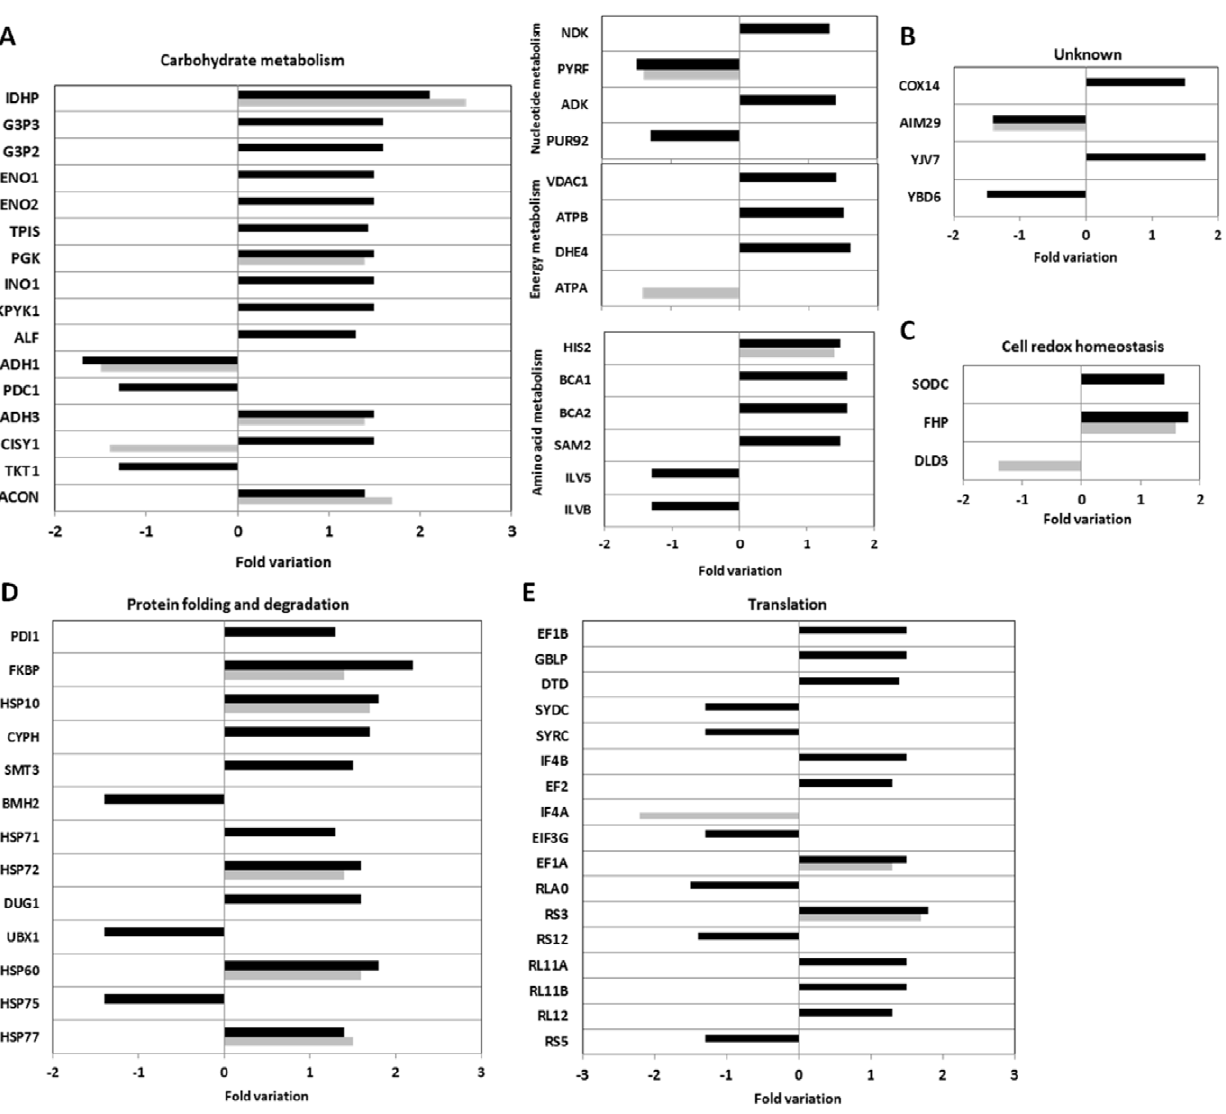
Figure 5. Detailed expression profiles for all the identified differentially expressed proteins, according to its functional categories: (A) cell metabolism; (B) unknown function; (C) Cell redox homeostasis; (D) protein folding and degradation; (E) translation. Grey bars represent fold change in protein expression in BTTR-wt versus the control while black bars represent fold change in protein expression in BTTR- L55P versus the control. The vertical axis indicates the identified protein while the horizontal axis represents the fold variation in protein expression. Additional information for each protein, including full name, can be found in Table 1. For proteins identified in different spots (with slightly different fold variations) the average is represented in the graph.